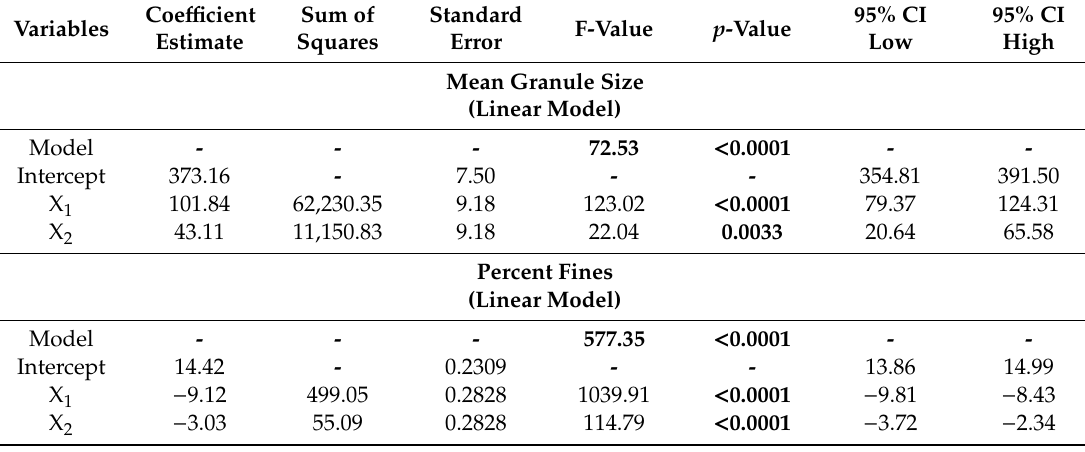
Table 7. Analysis of variance (ANOVA) summary and regression analysis of granules dependent responses. CI, confidence